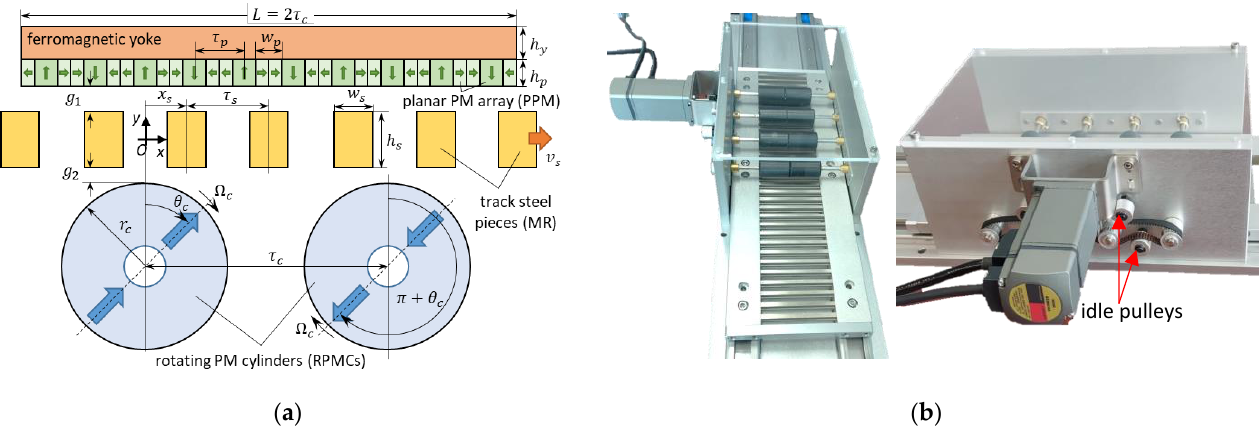
Figure 1. ( a ) RLMC basic module; θ c , x s : RPMC angular position and MR linear position with respect to the fixed reference frame Oxy ; v s , Ω c : MR relative speed and RPMC angular speed; ( b ) small-scale prototype under development with moving MR and stationary PPM and RPMCs ( n m = 2